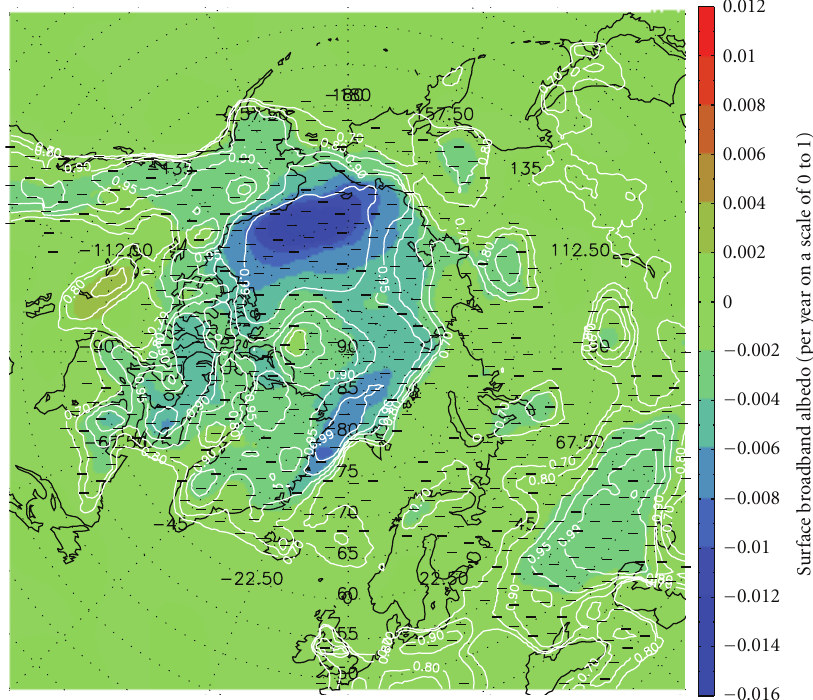
Figure 5: As in Figure 4, but for the surface albedo trend in autumn (September, October, and November, SON). Areas with decreasing trends are marked with